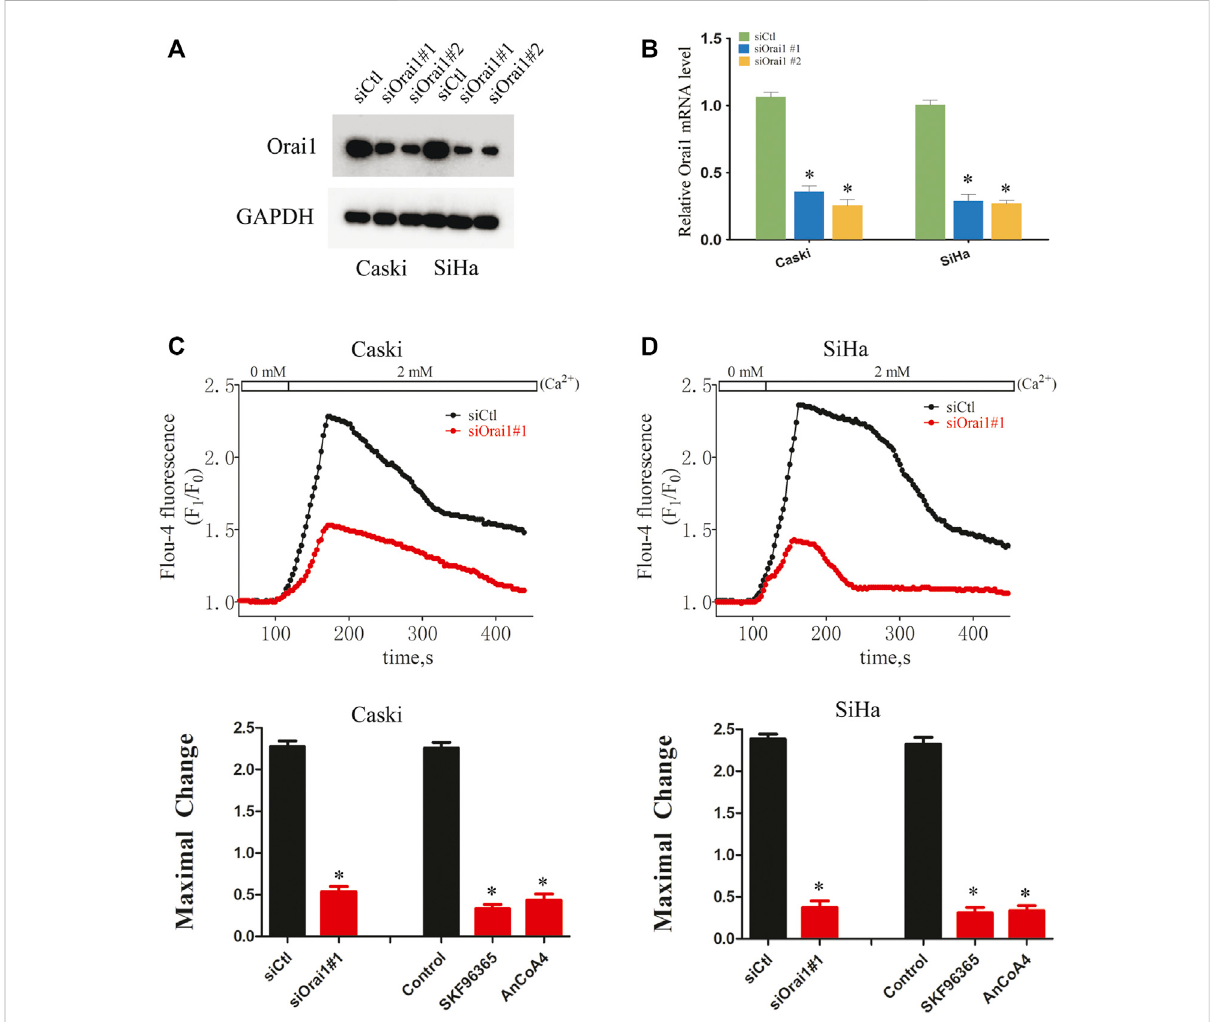
FIGURE 2 Orai1 mediates SOCE in cervical cancer cells (A) Immunoblot showing Orai1 protein levels in Caski and SiHa cells transfected with si-Orai1. (B) Relative Orai1 mRNA levels in Caski and SiHa cells transfected with si-Orai1. (C) Representative images and SOCE measurement in Caski cells transfected with siOrai1#1 or pre-treated with 10 μ M SKF96365 or 10 μ M AnCoA4. (D) Representative images and SOCE measurement in SiHa cells pre-treated as above. Values are means ± SEM, * p < 0.05 compared to siCtl or control